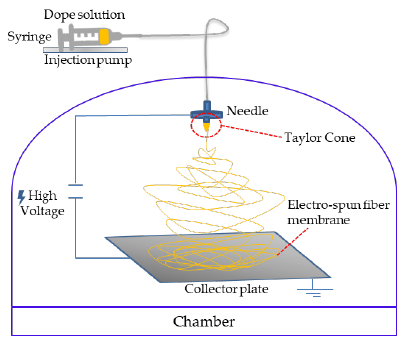
Figure 1. Schematic representation of the electrospinning set-up used in this study.